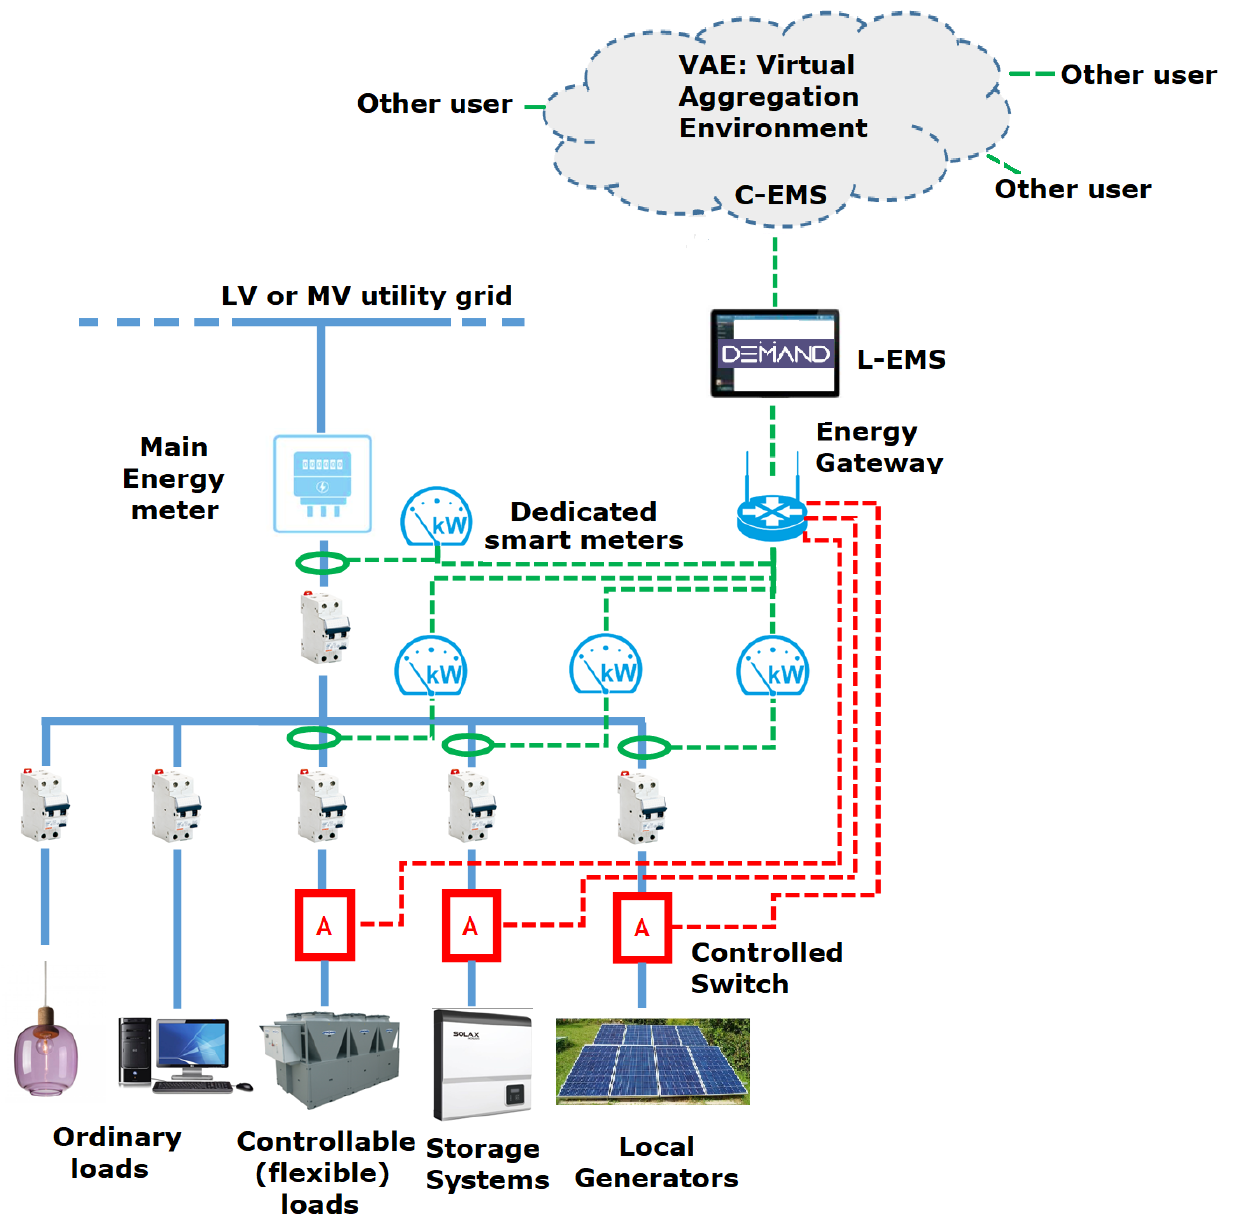
Figure 1. Concept of the